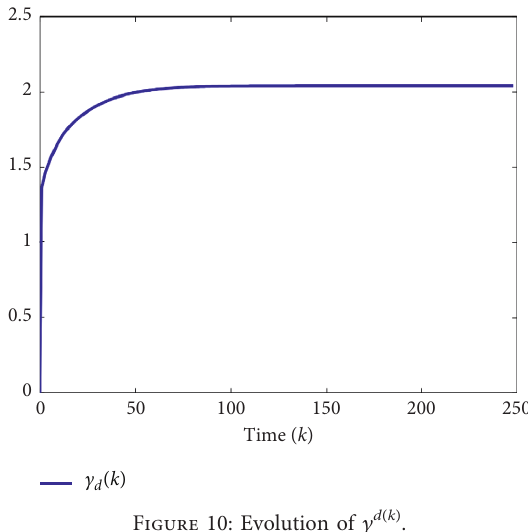
Figure 10: Evolution of γ d ( k )